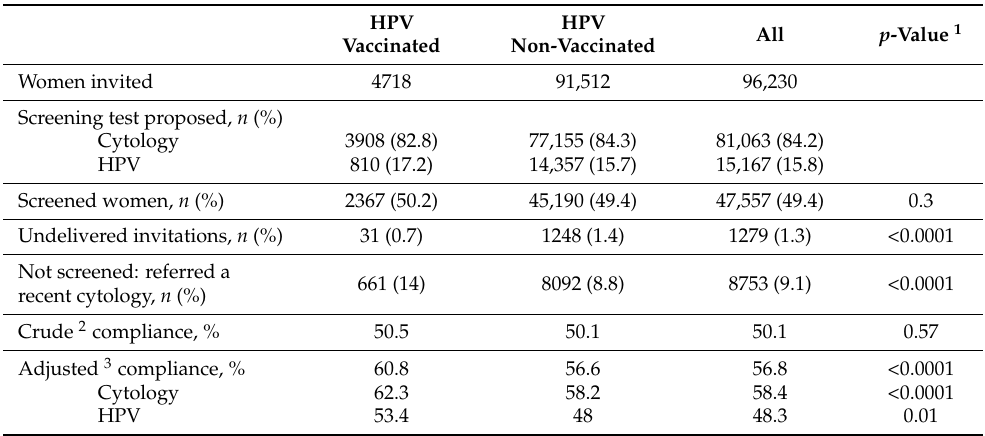
Table 1. Distribution of women among study cohorts (HPV-vaccinated vs. HPV-non-vaccinated) and compliance with screening invitation. HPV Vaccinated